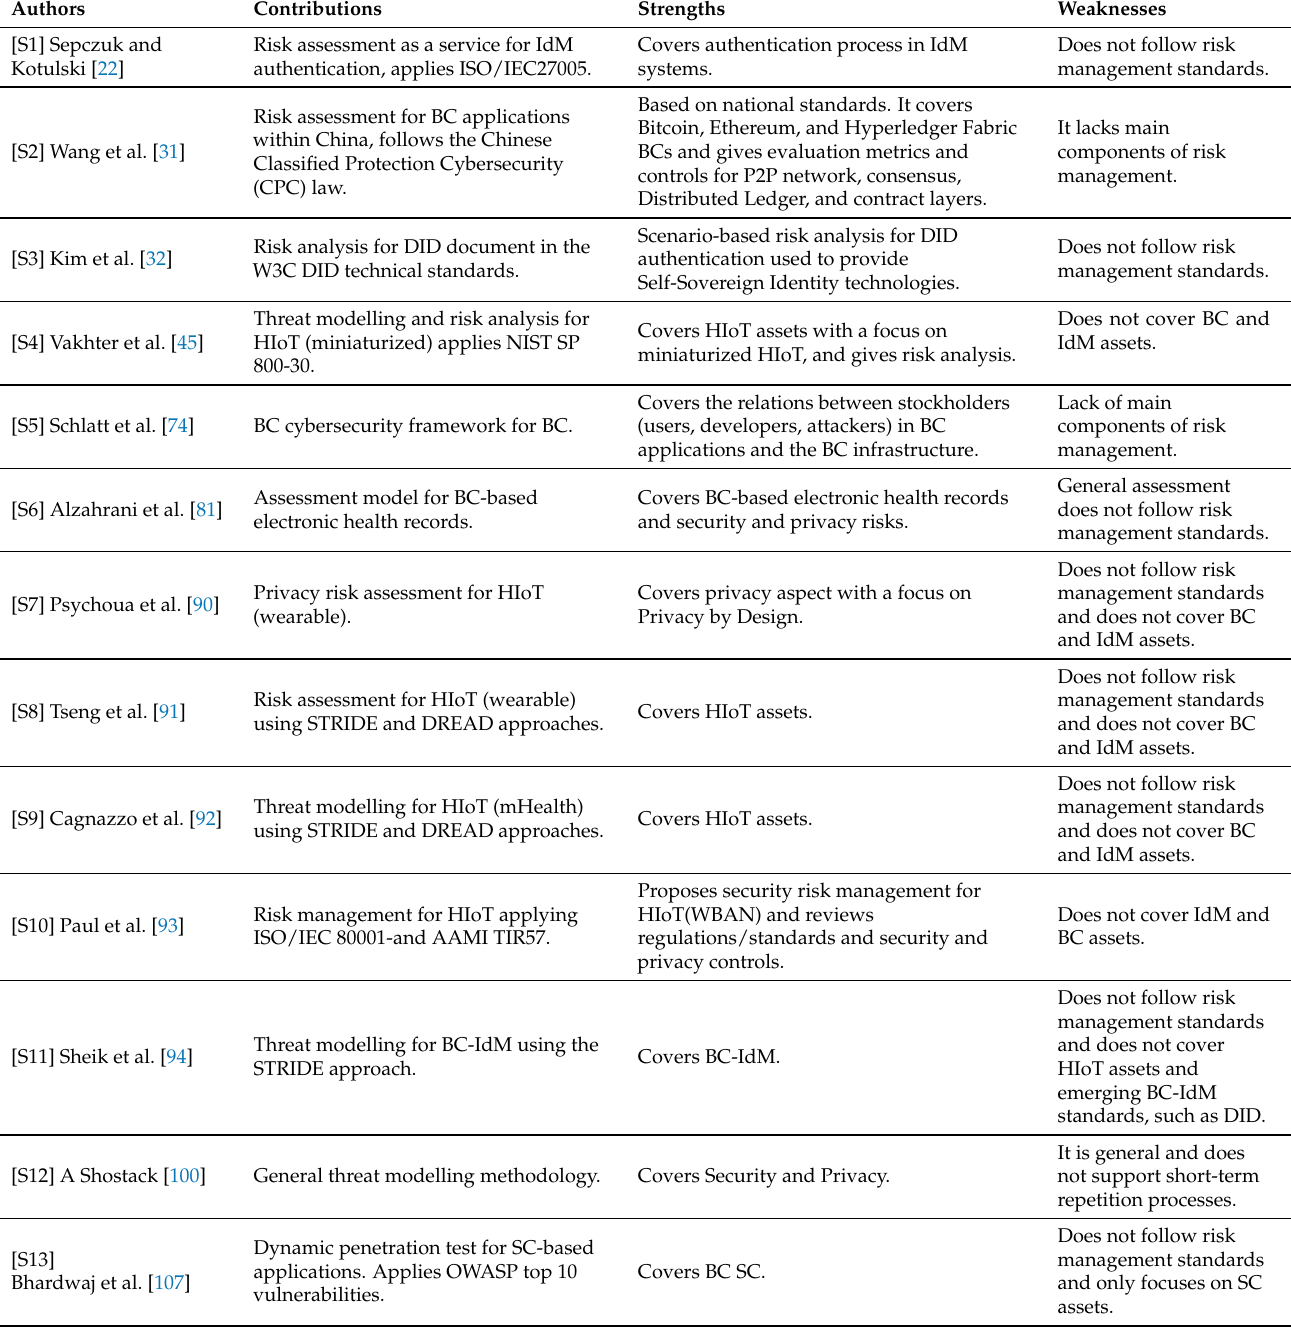
Table 10. A comparison between HIoT BC-IdM cybersecurity risk framework